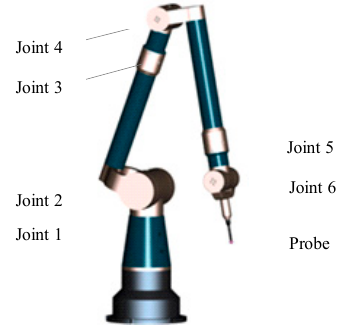
Figure 1. Structure of an articulated arm coordinate measuring machine (AACMM).